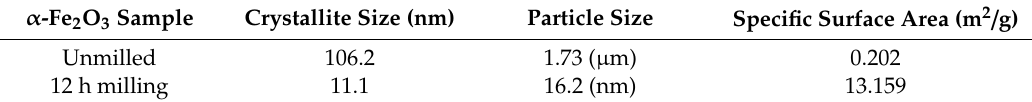
Table 1. Crystallite size, particle size and specific surface area as a function of milling time.